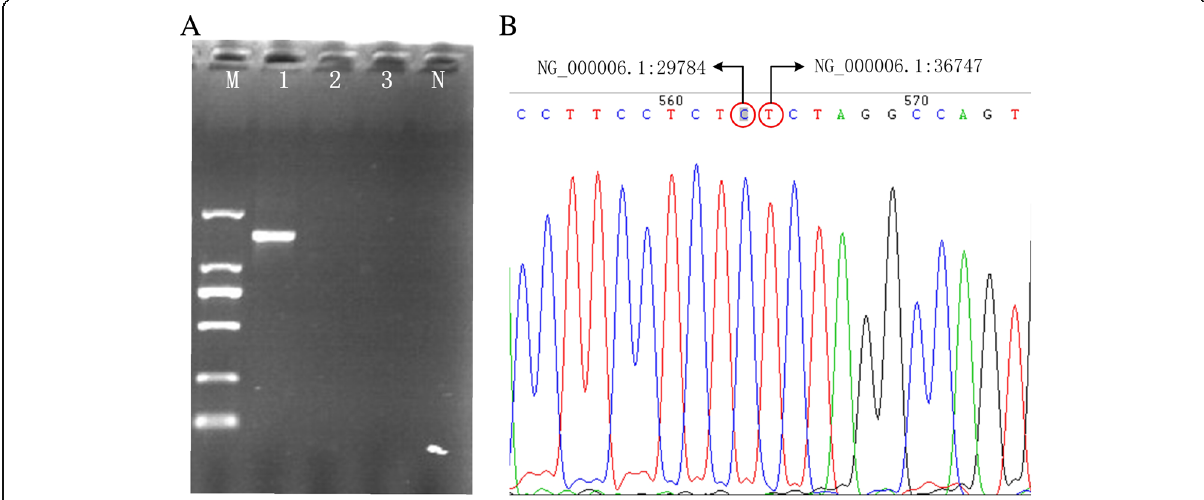
Fig. 3 Polymerase chain reaction and sequencing analysis. a The PCR products were generated from the proband using primers P1 and P2. A unique 1.4 kb product was amplified in the sample of the proband, whereas DNA from Proband ’ s wife and son, and the normal individuals all failed to amplify this abnormal fragment. The 1.4 kb product was sequenced to determine the precise breakpoint of this deletion. M: DL2000 DNA marker. 1: Proband. 2: Proband ’ s wife. 3: Proband ’ s son. N: normal individuals. b Characterization of the breakpoints of this novel deletion by direct sequencing. Sequence analysis of the amplification obtained with gap-PCR using primers P1 and P2 helped us to characterize the breakpoints. As shown in the figure, a 6962bp sequence deletion (NG_000006.1: g.29785_36746) existed in the novel